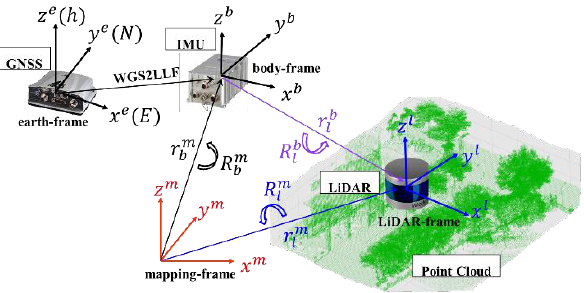
Figure 2 . Transformation relationship between different frames.